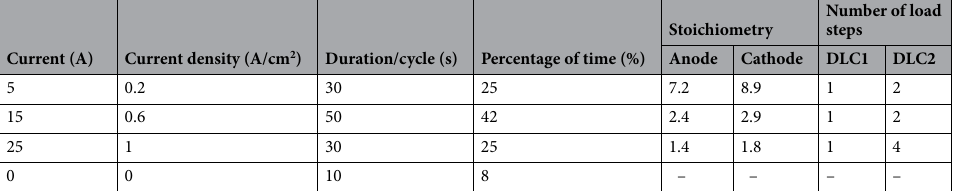
Table 3. Load profile of dynamic load cycle test.